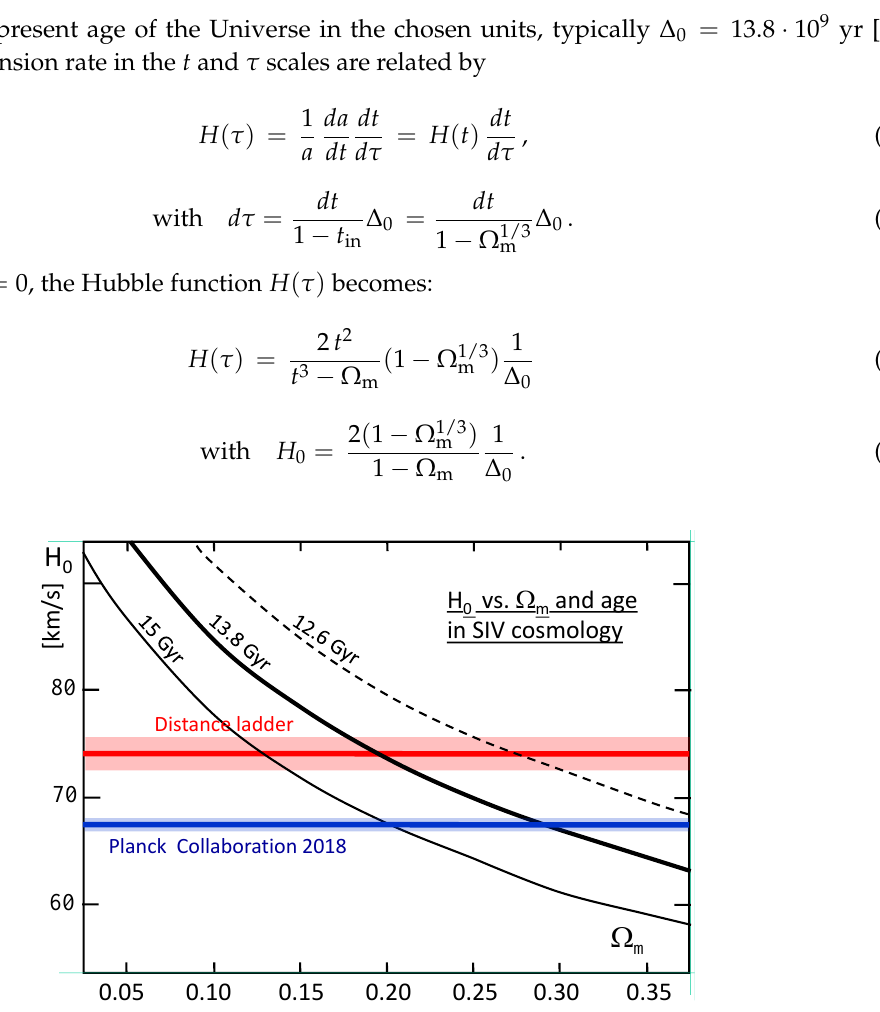
Figure 3. The relation between the Hubble constant H 0 and Ω m predicted by the SIV theory (Equation (57)) for three different values of the age of the Universe. The result from the distance ladder with a new calibration of the LMC Cepheids of 74.03 ( ± 1.42 ) km s − 1 Mpc − 1 by Riess et al. [41] is indicated by a thick red line, with its uncertainty. The thick blue line indicates the value of 67.4 ( ± 0.5 ) km s − 1 Mpc − 1 obtained by the Planck Collaboration